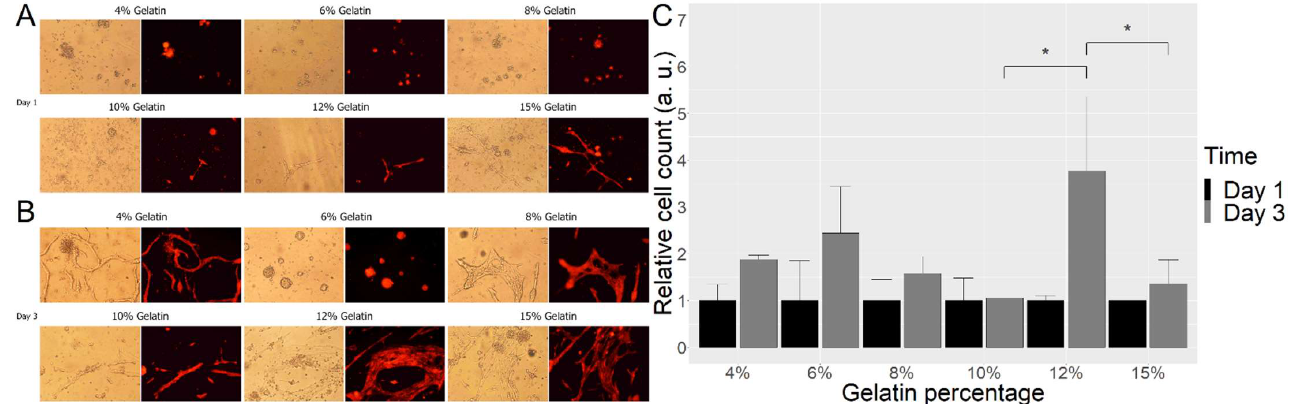
Figure 1. Images of BC on scaffolds from day 1 ( A ) and day 3 ( B ) with different concentrations of gelatin. Relative cell number on different scaffolds at day 1 and day 3 ( C ). Cell numbers on different concentrations of gelatin were assessed on day 1 and day 3 after attachment. For each concentration of gelatin, three random images of cultures were taken, and the number of cells estimated by ImageJ, via virtual measurement. Data and means are from three independent experiments. * p < 0.01. Scale bar A , B = 100 microns. Additional image with the scale bar.